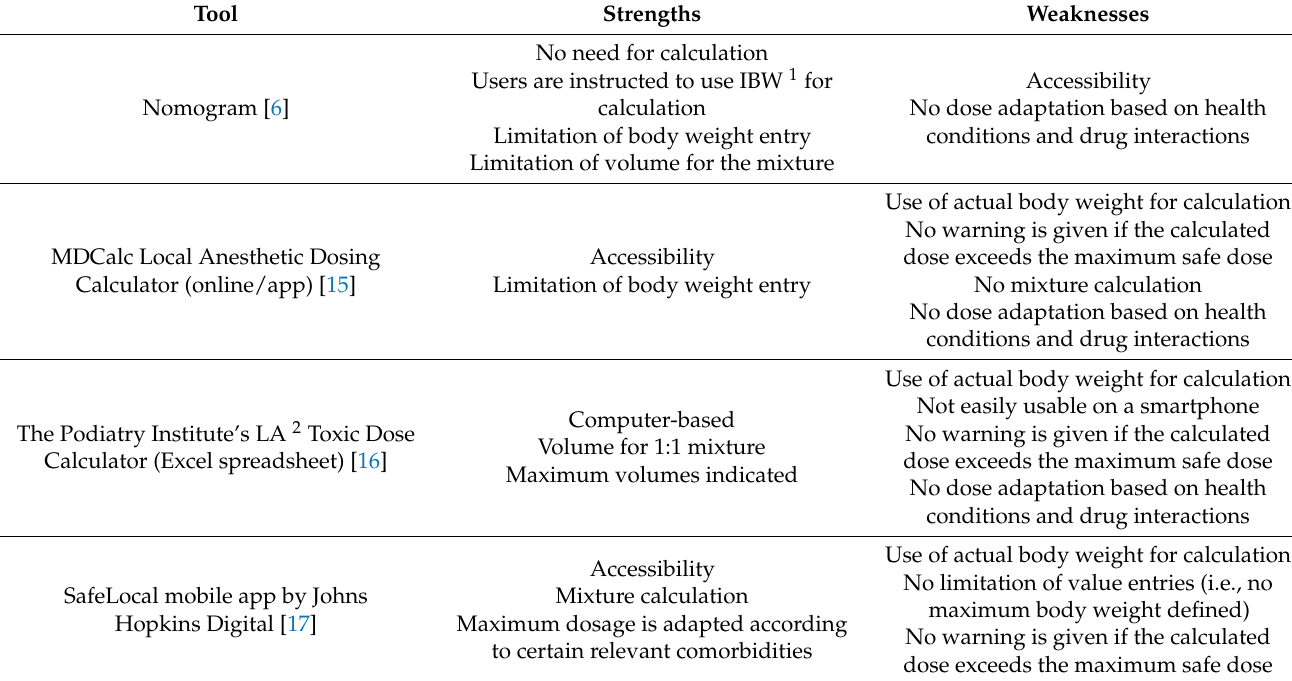
Table 2. Existing tools for local anesthetic dose